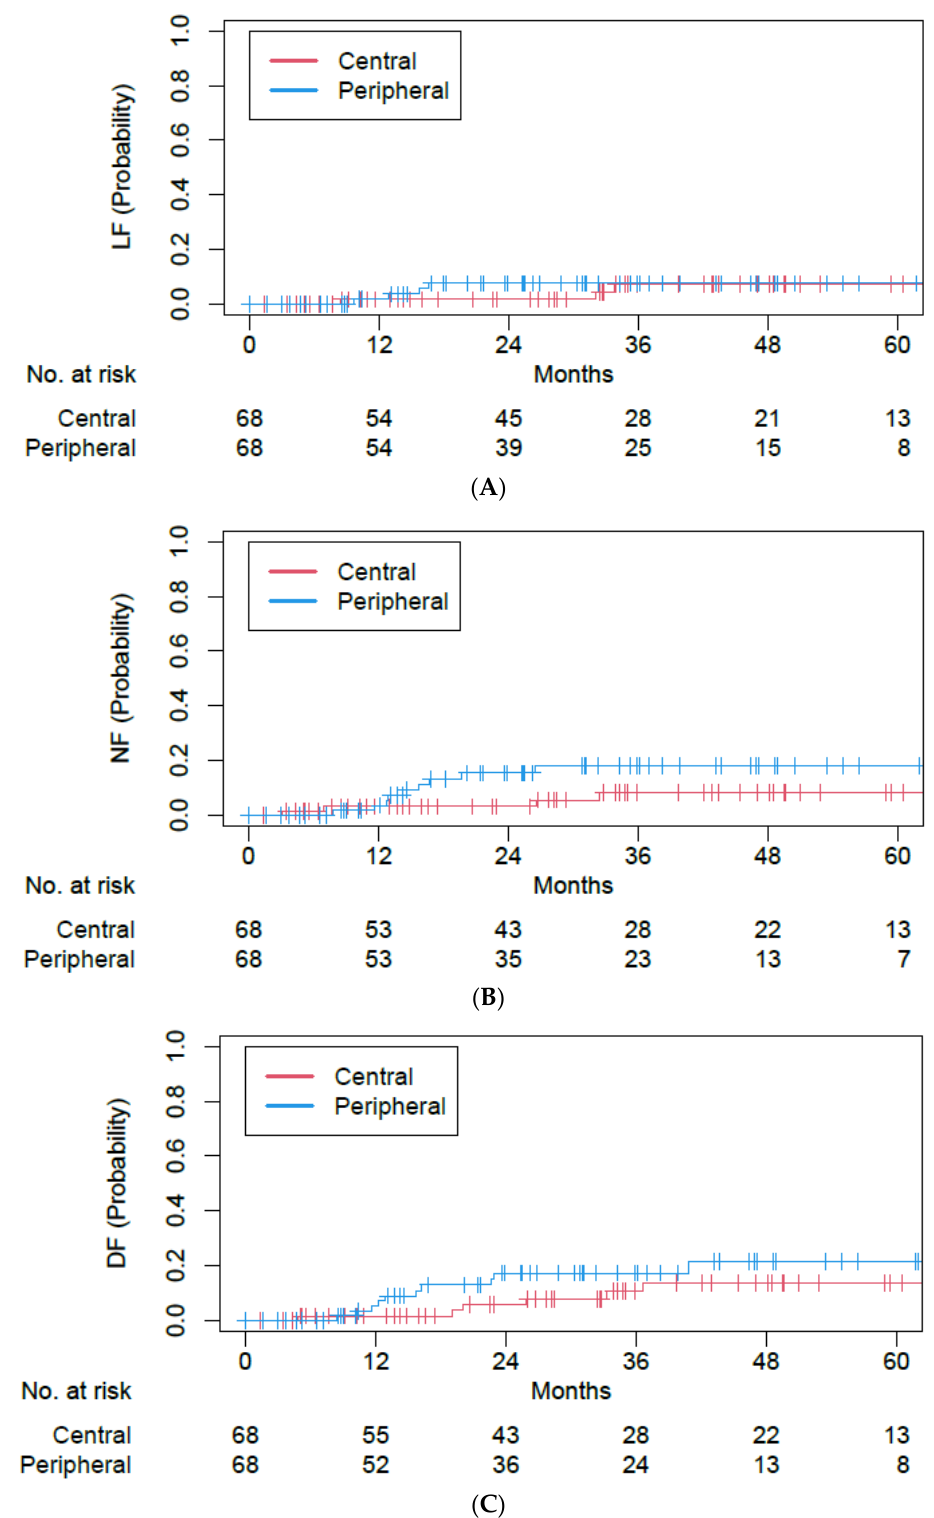
Figure 4. Cumulative incidence plots for ( A ) local failure, ( B ) nodal failure, and ( C ) distant failure outcomes among single- and five-fraction SBRT cohorts after propensity score matching.